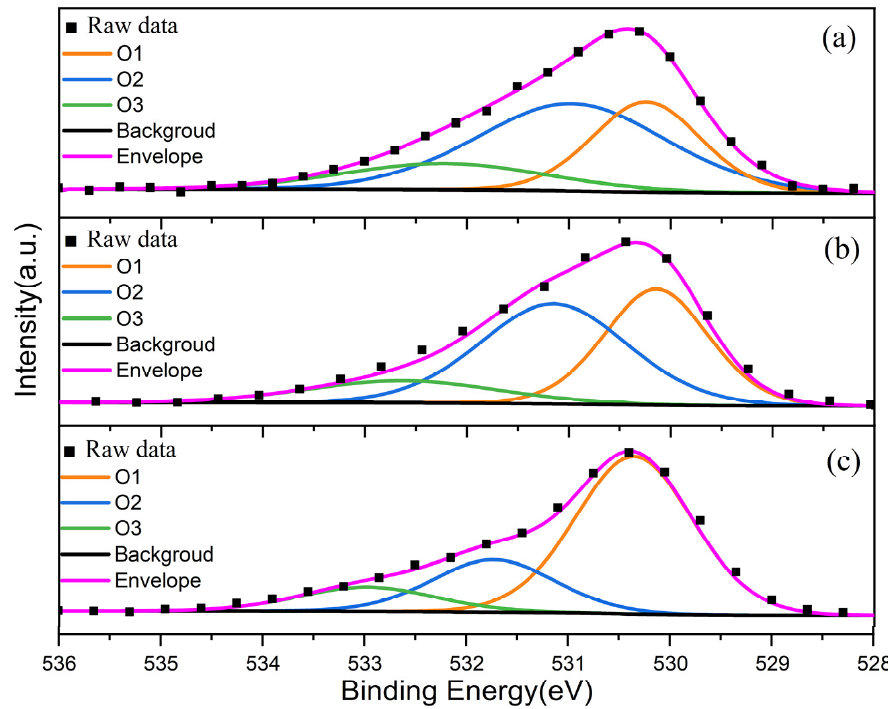
Figure 9. O1s of XPS spectrum for samples ( a ) 0% ZrH 2 , ( b ) 0.05% ZrH 2 and ( c ) 0.1% ZrH 2 . Figure 9b,c are the O1s spectra with 0.05% ZrH 2 and 0.1% ZrH 2 added, respectively, 7.2nα which show that the binding energy positions of O1 and O2 have changed significantly. For R (cid:2915)(cid:2911) = (1) R (cid:2872) + RDα the sample with 0.05% ZrH 2 , the binding energies of O1 and O2 are 530.14 and 531.15